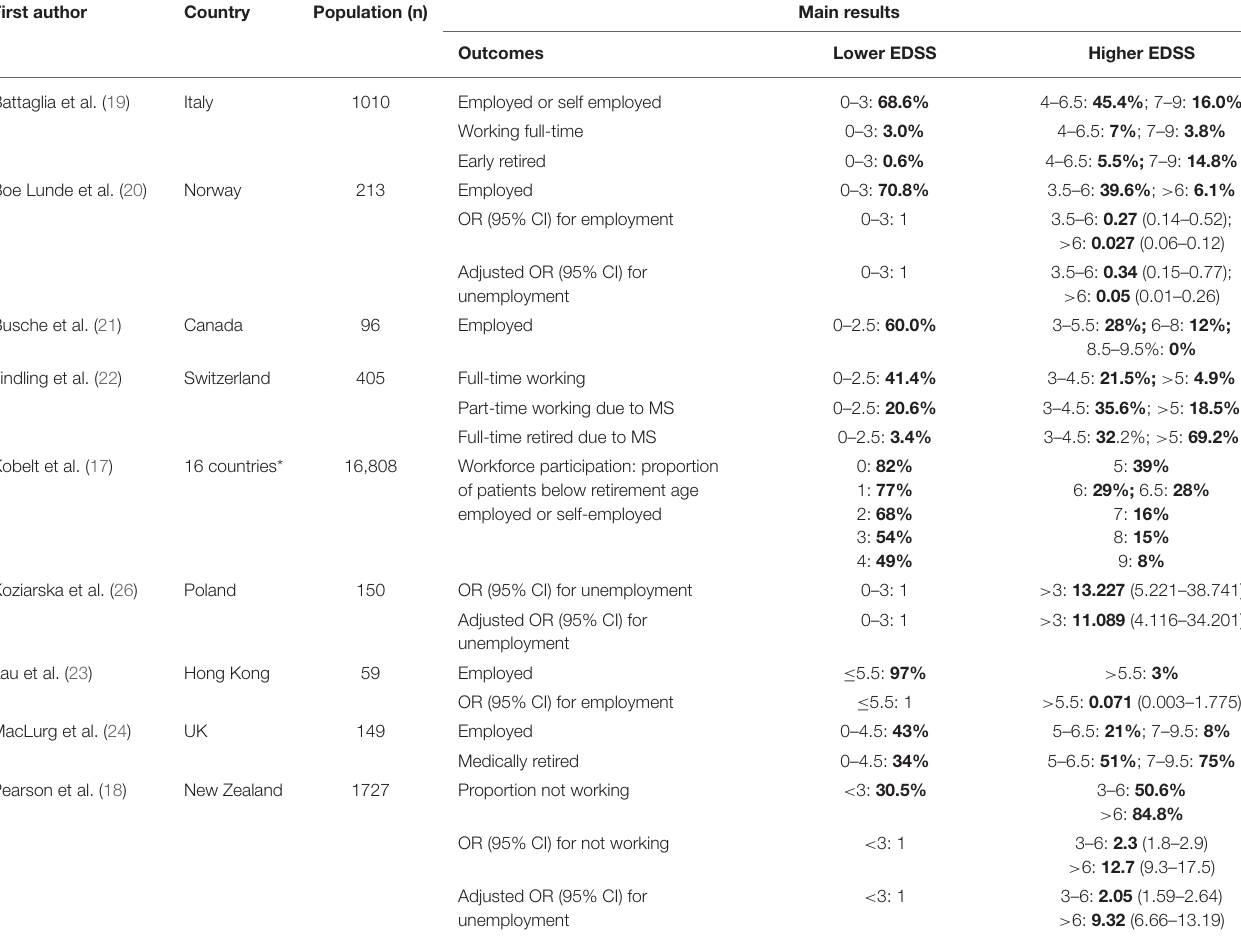
TABLE 2 | Studies that investigated employment-related outcomes in patients with multiple sclerosis (MS) within different levels of physical